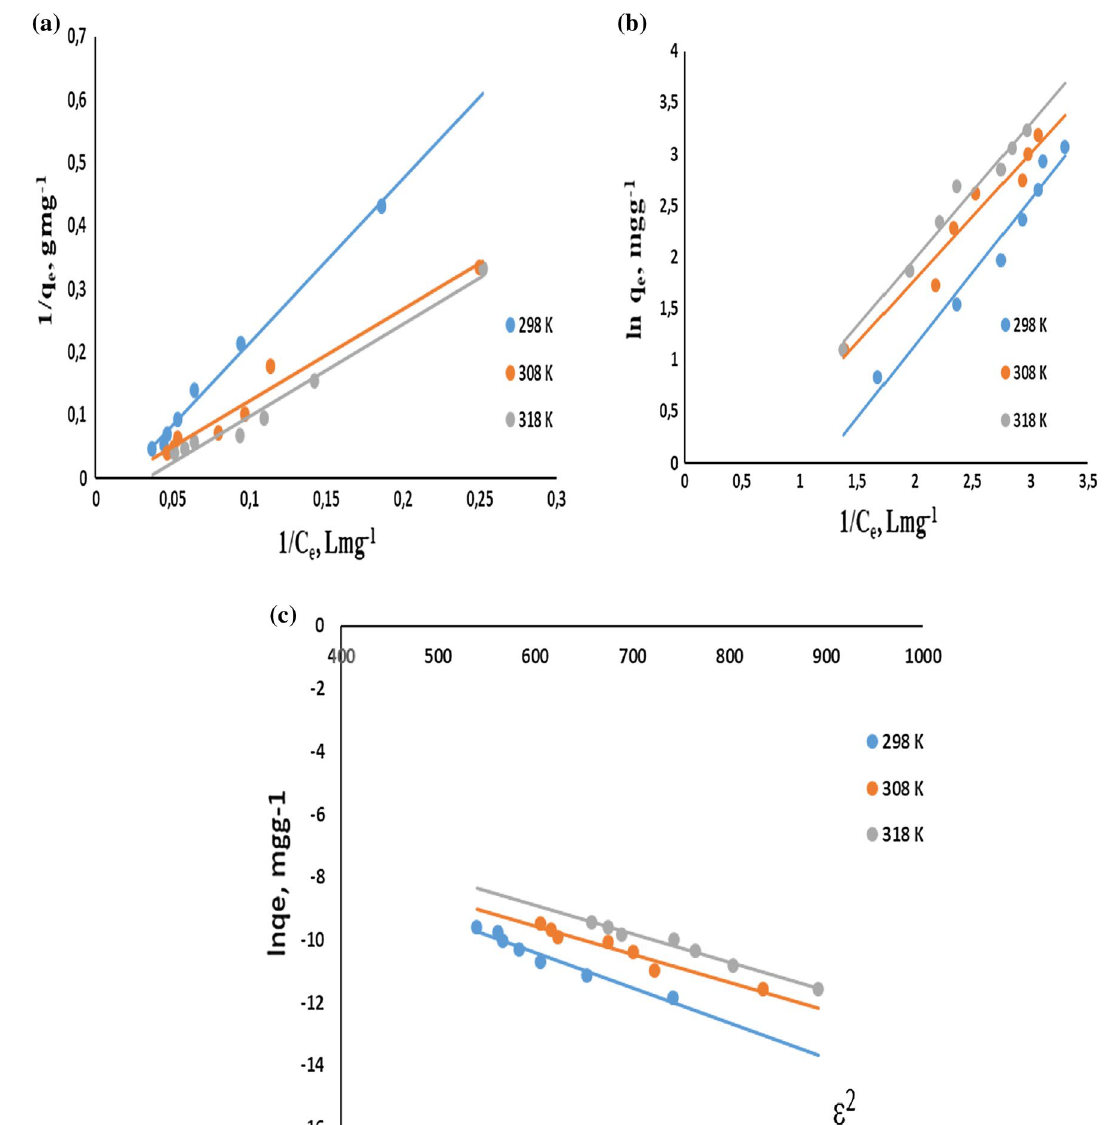
Fig. 9 The Langmuir isotherms a, the Freundlich isotherms b and the D–R isotherms c for the biosorption of MB onto the LPF at various tem-